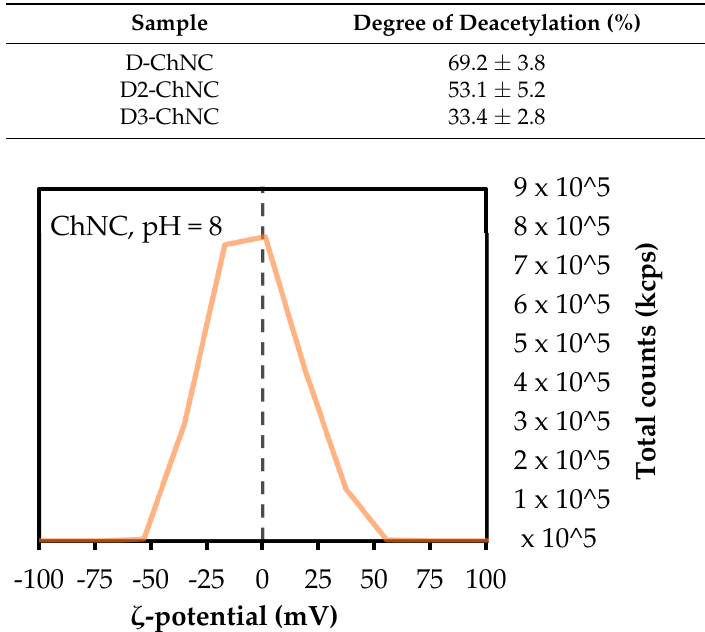
Figure A2. The ζ -potential (mV) distribution of ChNC at pH 8.